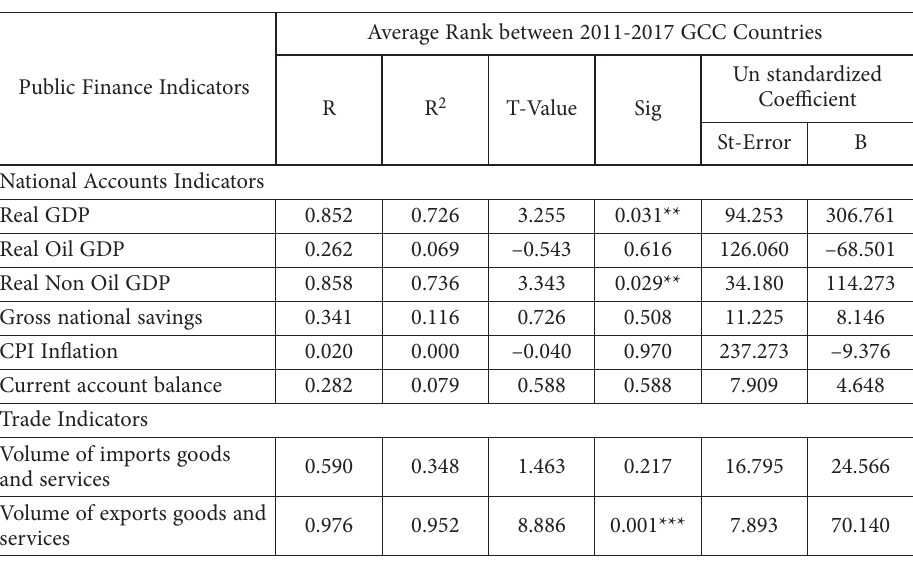
Table 9. Simple regression of public finance indicators on total value of projects planned or underway (source: OLS regression analysis test from SPSS program. Denote *Sig at p <0.10 ** Sig at p< 0.05 *** Sig at p< 0.01) (